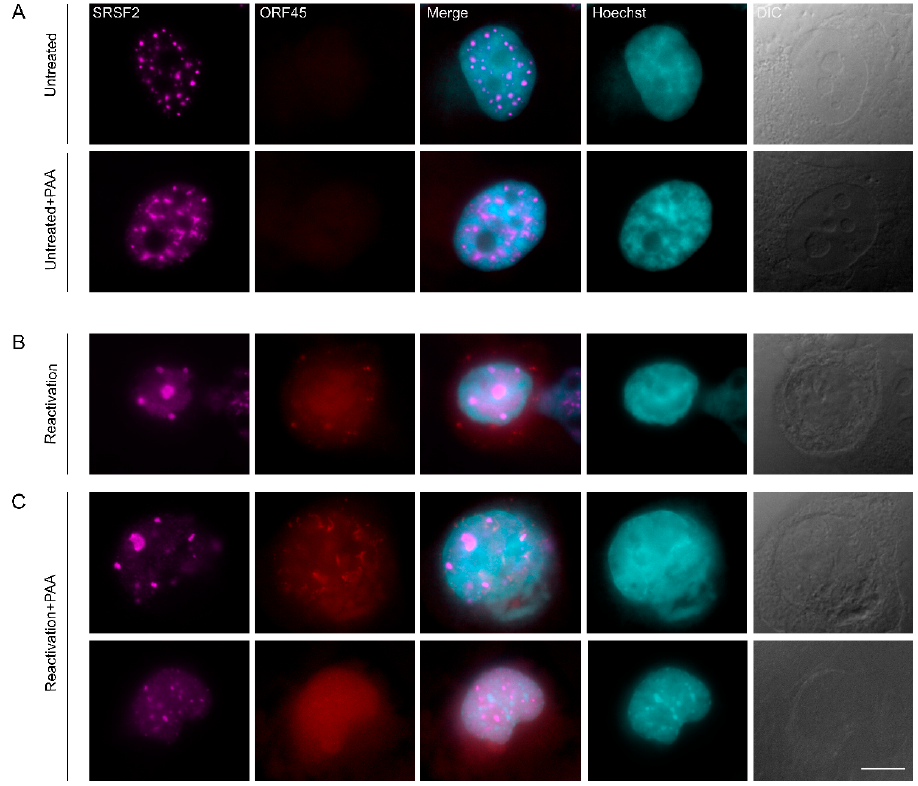
Figure 5. Inhibition of viral DNA replication and late gene expression does not prevent changes in nuclear structure. ( A ) Nuclear speckles (SRSF2, magenta) in BAC16-infected mCherryORF45 iSLK